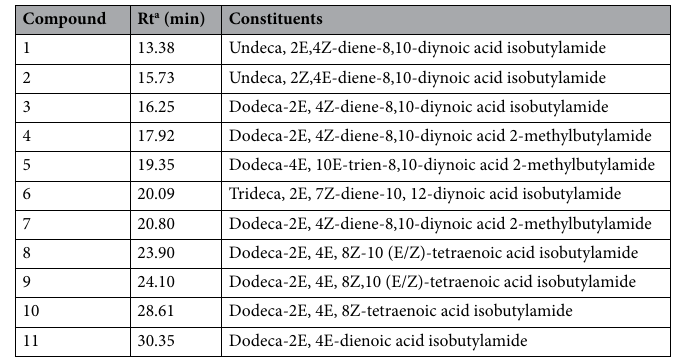
Table 2. Alkylamide composition of E. purpurea . a Retention time in HPLC system.